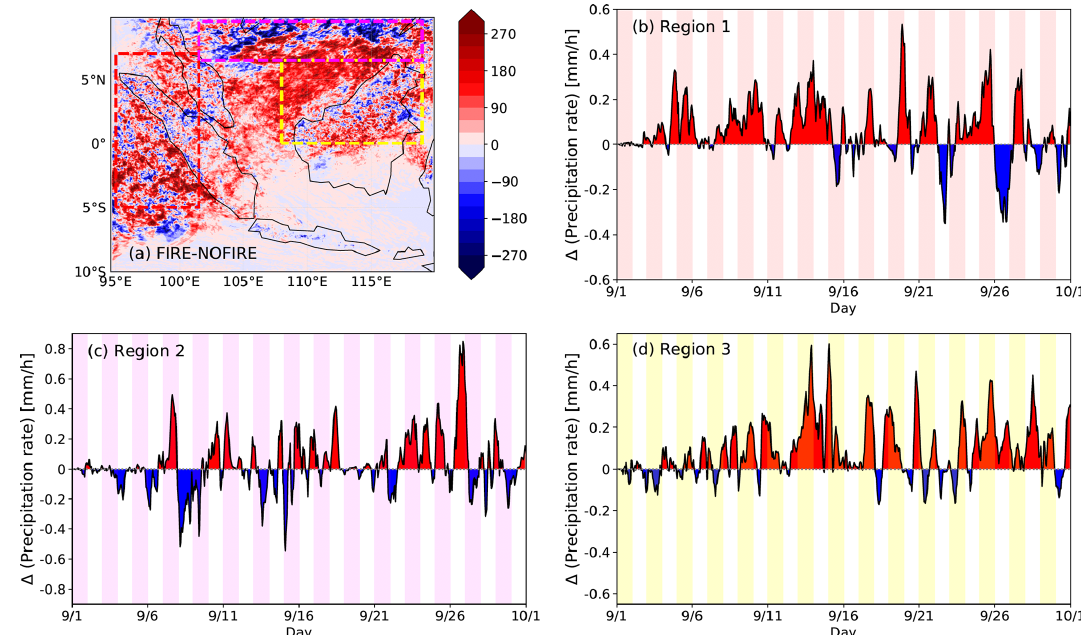
Figure 9. (a) Difference (FIRE − NOFIRE) in accumulated precipitation (mm) over the month of September. (b–d) Time series of regional mean precipitation rate (mmh − 1 ) differences (FIRE − NOFIRE) in (b) Region 1, (c) Region 2, and (d) Region